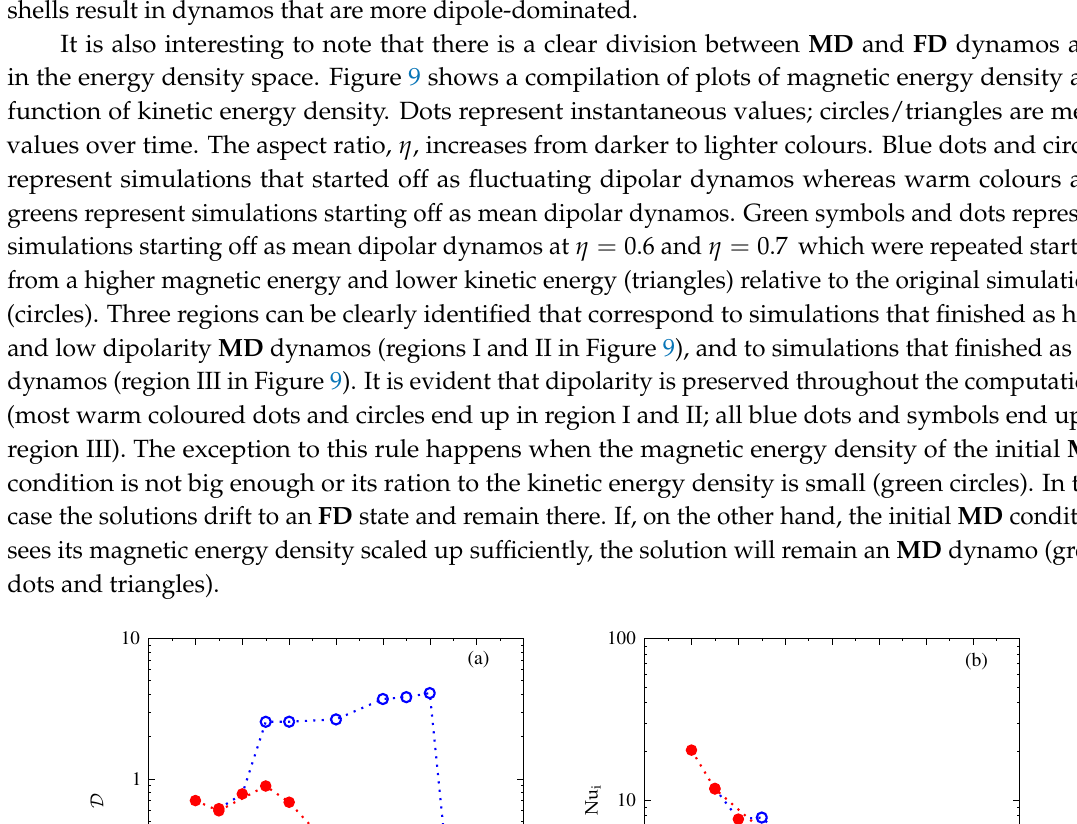
Figure 8. Bistability as a function of the shell thickness aspect ratio η . ( a ) The dipolarity ratio M p / (cid:101) M p and ( b ) the Nusselt number at r = r i in the cases R = 3.8 P m = 1.5. Full red and empty blue circles indicate FD and MD dynamos, respectively. Red dotted lines and blue dotted lines connect dynamos that were started from FD and MD initial conditions, respectively. (Colour